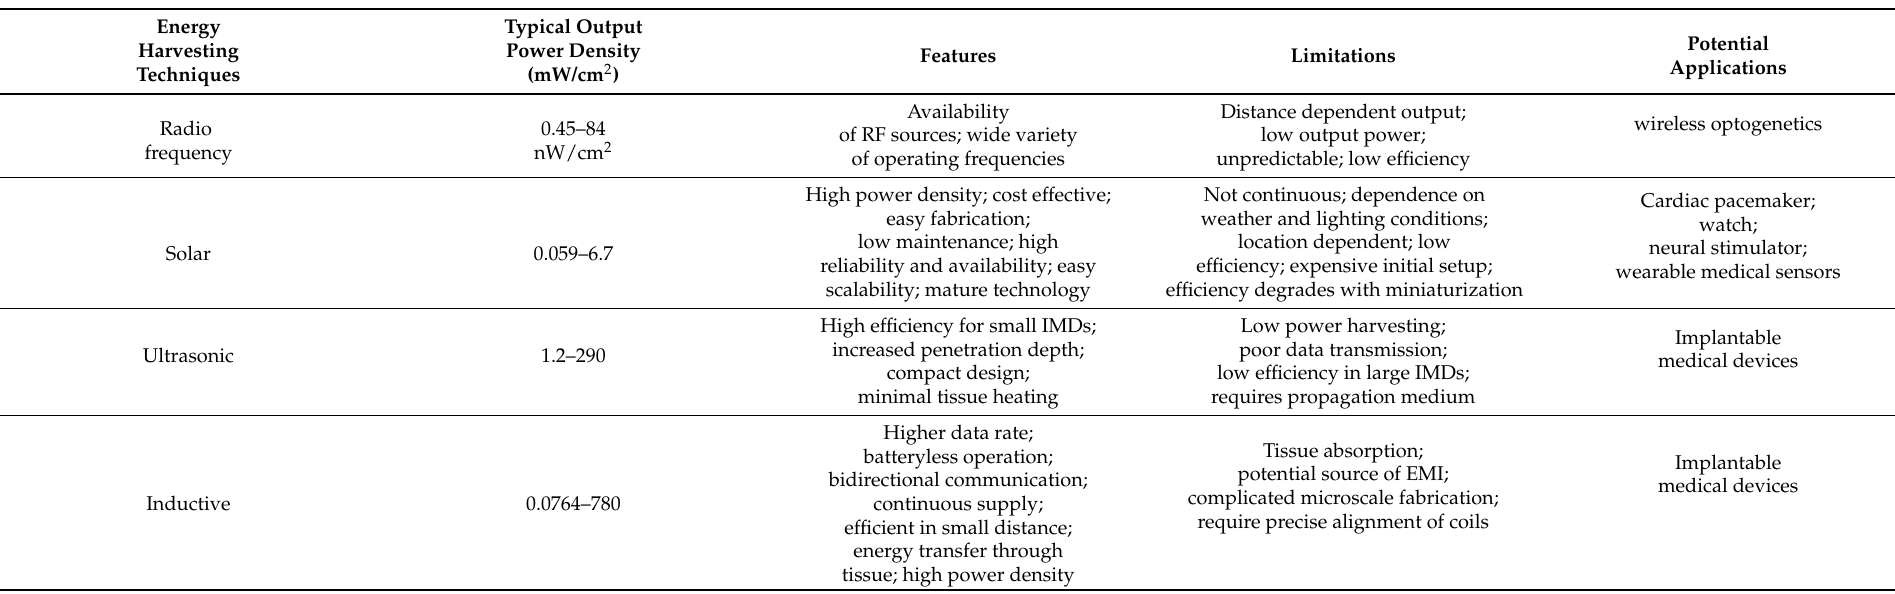
Table 7. Comparison of different environment-centric energy harvesting techniques having potential application in implantable and wearable medical